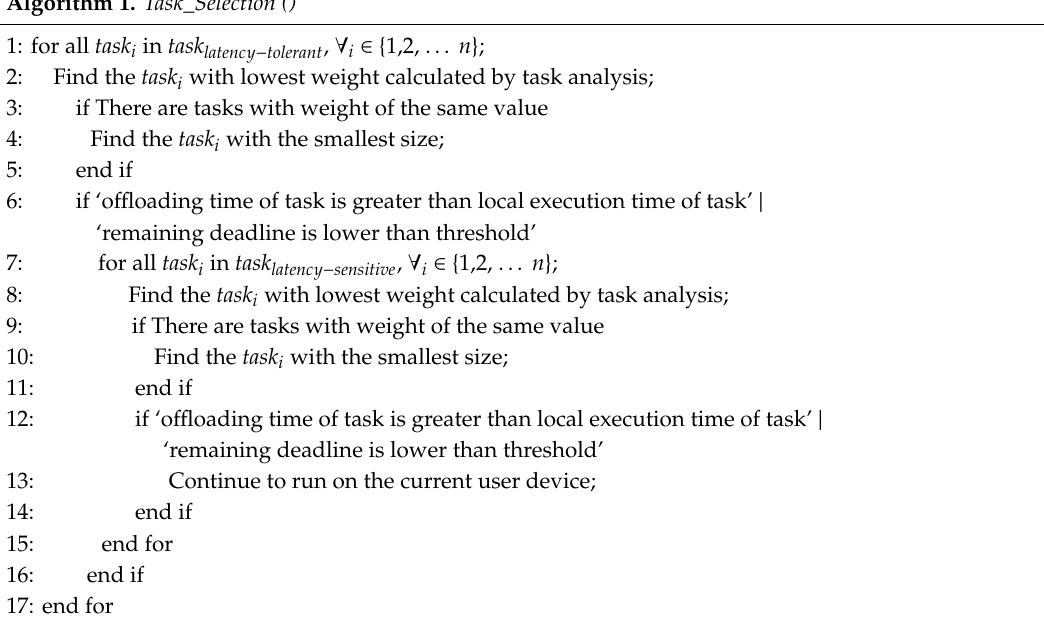
Algorithm 1. Task_Selection